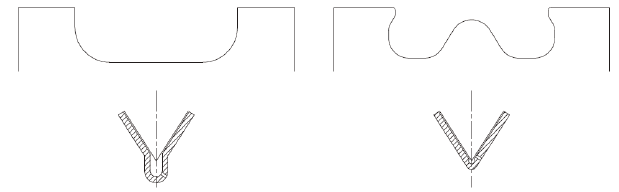
Fig. 11. Geometry of the combustion chamber and the nozzle endings; standard version – left, modified version – right [11]